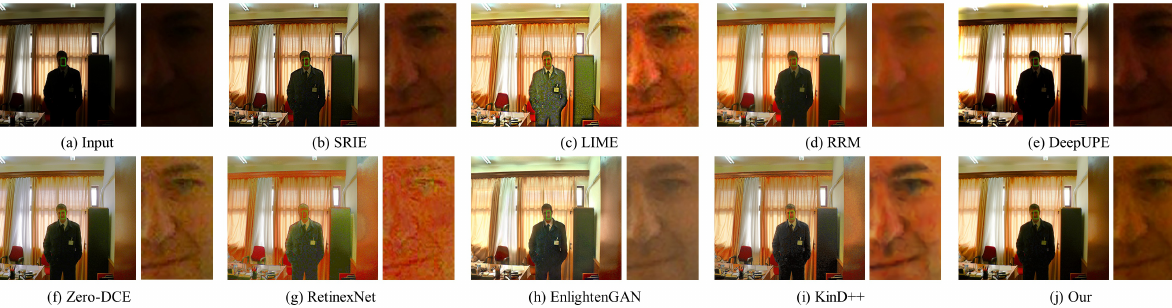
Figure 9. Visual comparison of low-light image enhancement on an image from the VV